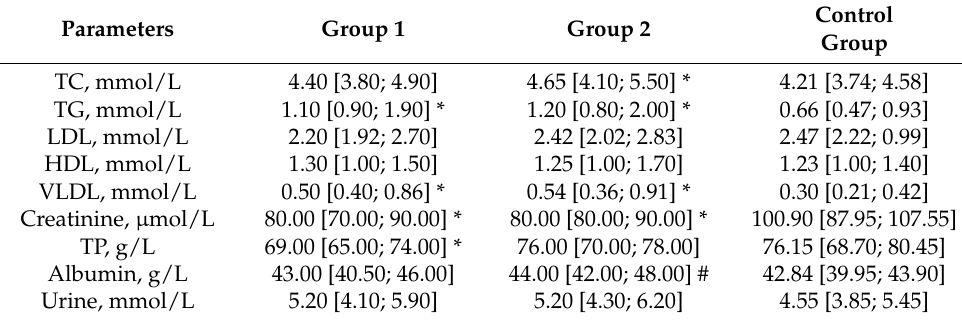
Table 2. Biochemical blood parameters in men with T1DM (Me, [Q1; Q3]).